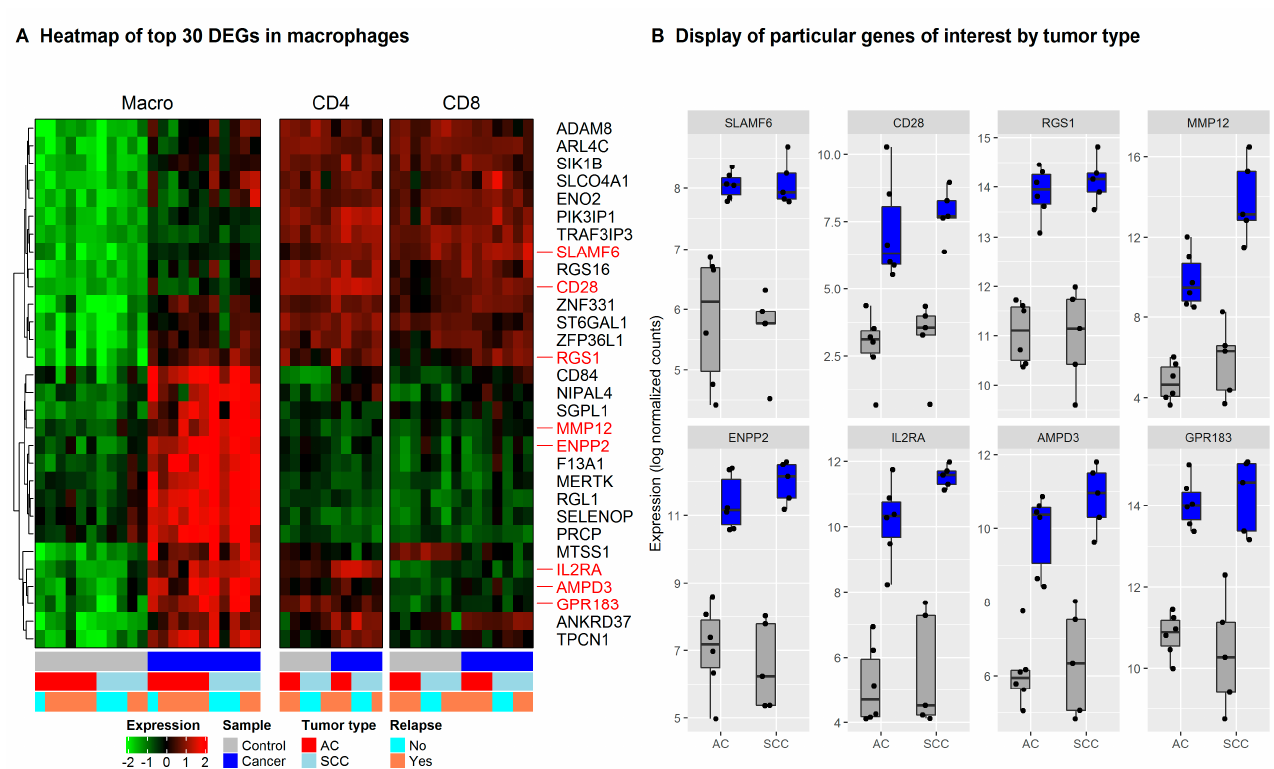
Figure 2. Top 30 differentially expressed genes (DEGs) in macrophages in NSCLC compared to lung tissue. Legend: ( A ) The lists of DEGs from macrophages (NSCLC versus lung tissue) were sorted for adjusted p -values and displayed in heatmaps. Expression of the top 30 macrophage DEGs is shown in macrophages (left), CD4 + (middle), and CD8 + T cells (right). Names of genes of particular interest are highlighted in a red color. The internal order of genes (rows) in the heatmap is disrupted by hierarchical clustering of the genes to group genes with a similar pattern of expression in each immune cell subset. The color code below the heatmaps indicates the origin of the immune cell samples. Data was sorted into samples from normal lung tissue (grey) or cancer (blue) origin and into adenocarcinoma (AC) or squamous cell carcinoma (SCC) patients. Some patients indicated experiencing a relapse within 24 months after surgery. ( B ) Boxplots showing expression profiles for individual genes of interest in macrophages isolated from healthy tissue (grey) and lung cancer (blue), by tumor